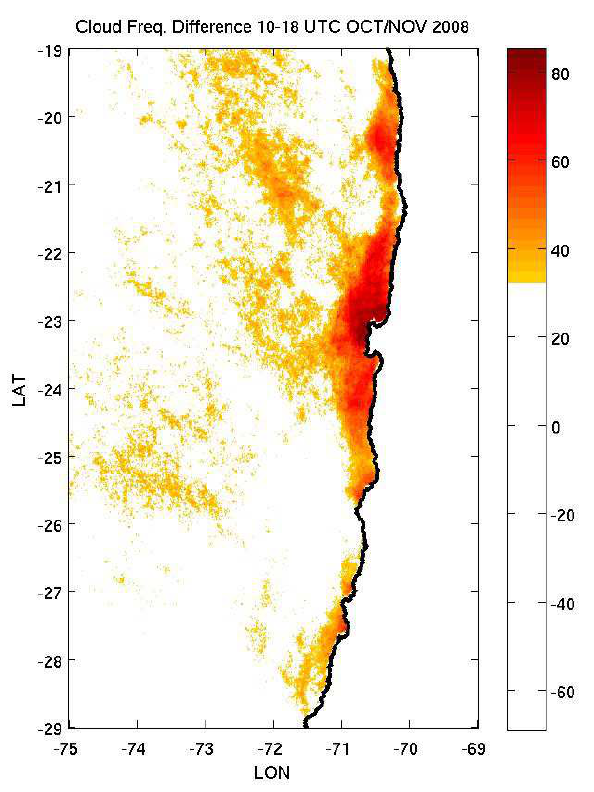
Fig. 6. Early morning (10:00UTC) minus early afternoon (18:00UTC) cloud frequency diagnosed from GOES visible im- Figure 6. Early morning (10 UTC) minus early afternoon (18 UTC) cloud frequency 2 agery analysis for October–November 2008. A reflectivity thresh- old of 0.04 (0.10) was used to distinguish between cloudy and diagnosed from GOES visible imagery analysis for October-November 2008. A reflectivity 3 clear pixels in the visible image closest to 10:00UTC (18:00UTC). threshold of 0.04 (0.10) was used to distinguish between cloudy and clear pixels in the visible 4 Cloud frequency drops below 30% and over the continent have been masked image closest to 10 UTC (18 UTC). Cloud frequency drops below 30% and over the continent 5 have been masked out. 6